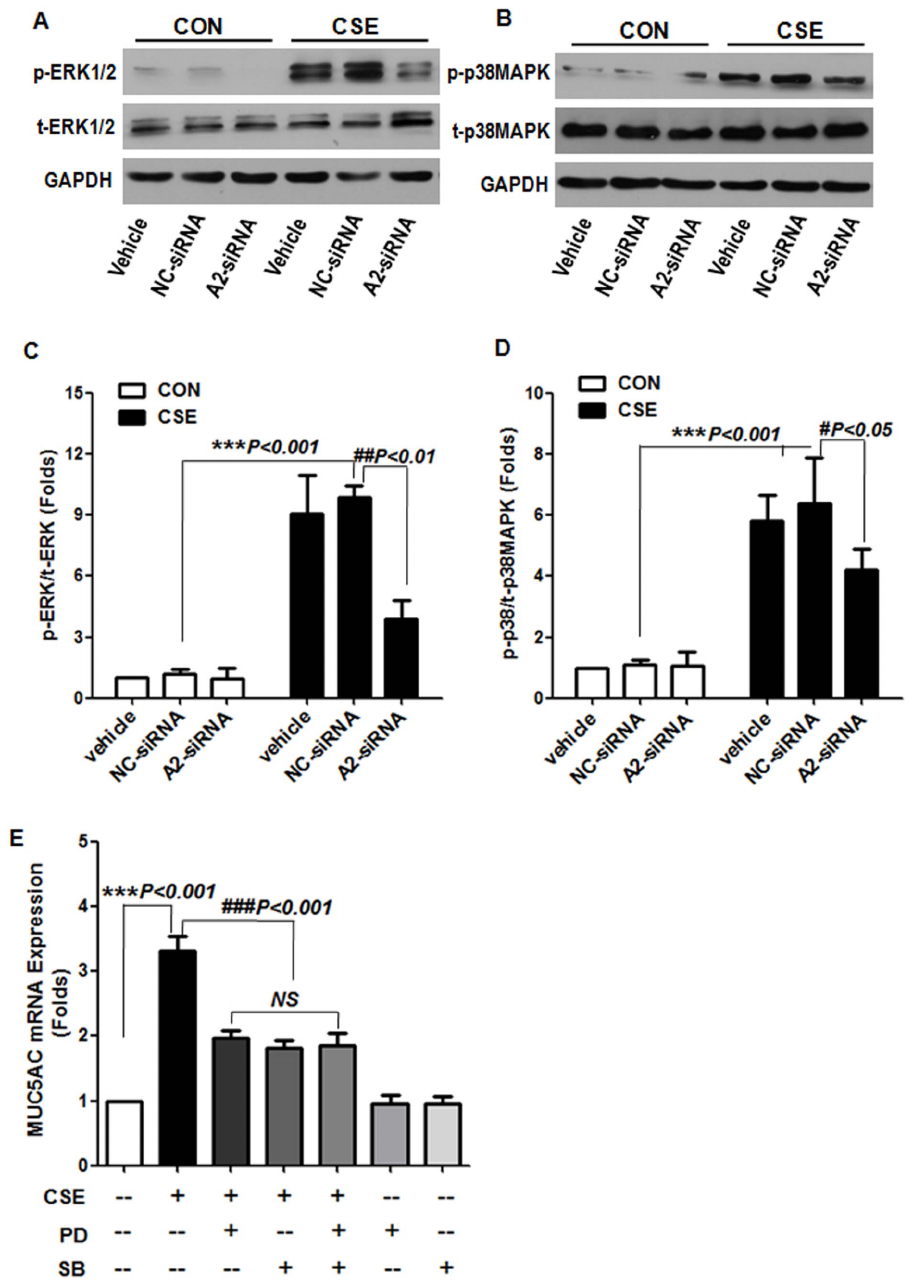
Figure 5. Effect of b -arrestin knockdown on CSE-stimulated MAPK activation. Western blot analysis of phospho-ERK1/2 (p-ERK1/2), total ERK1/2 (t-ERK1/2), phospho-p38MAPK (p- p38MAPK) and total p38MAPK (t-p38MAPK) in cells treated with Lipofectamine2000 (vehicle), nonspecific control siRNA (NC-siRNA, 100 nM) or b -arrestin2–targeted siRNA (A2-siRNA, 100 nM) before CSE stimulation as in Figure 4. (A, B) Representative western blot is from 3 independent experiments. (C, D) Data are the means 6 SEM of 3 separate experiments. Cells were pretreated with ERK1/2 inhibitor PD98059 (50 m M) or p38MAPK inhibitor (5 m M) for 60 min before CSE treatment. (E) Quantitative RT-PCR analysis of MUC5AC mRNA expression. Data are means 6 SEM (n=3). NS, not